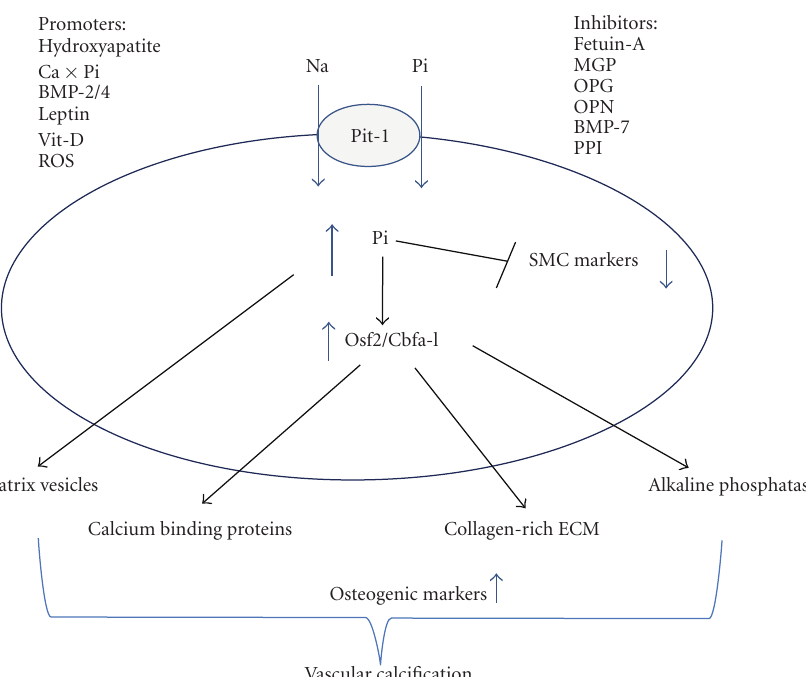
Figure 1: Mechanisms of VSMC osteogenesis during vascular calcification in chronic kidney disease. VSMC upregulate expression of transcription factors Osf2/Cbfa1 which were enhanced by ROS, leptin, vitamin D, increased CaxP product, or high PO 4 (Pi) levels induced by Pit-1. VSMC activation occurs in part as a result of the phenotypic switch of VSMCs into osteoblast-like cells. VSMCs that have acquired an osteogenic phenotype express ALP and produce hydroxyapatite crystals. Calcification inhibitors such as PPi inhibit hydroxyapatite precipitation, whereas fetuin-A, MGP, OPG, OPN, and BMP-7 antagonize calcification. VSMC: Vascular smooth muscle cells, Osf2/Cbfa1: Osteoblast-specific transcription factor, ROS: Reactive oxygen species, CaxP product: Calciumx phosphate produce, PO4(Pi): Phosphate, Pit- 1: Sodium-phosphate cotransporter-1, ALP: Alkaline phosphatase, PPi: Pyrophosphate, MGP: Matrix Gla protein, OPG: Osteoprotegerin, OPN: Osteopontin, BMP: Bone morphogenic